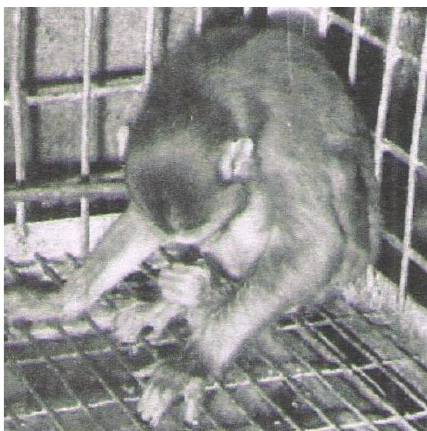
Figure 1: Photograph of monkey 46DPI fed 12,000 eggs showing acute pressure syndrome and rapidly developing paralysis of hind quarter.